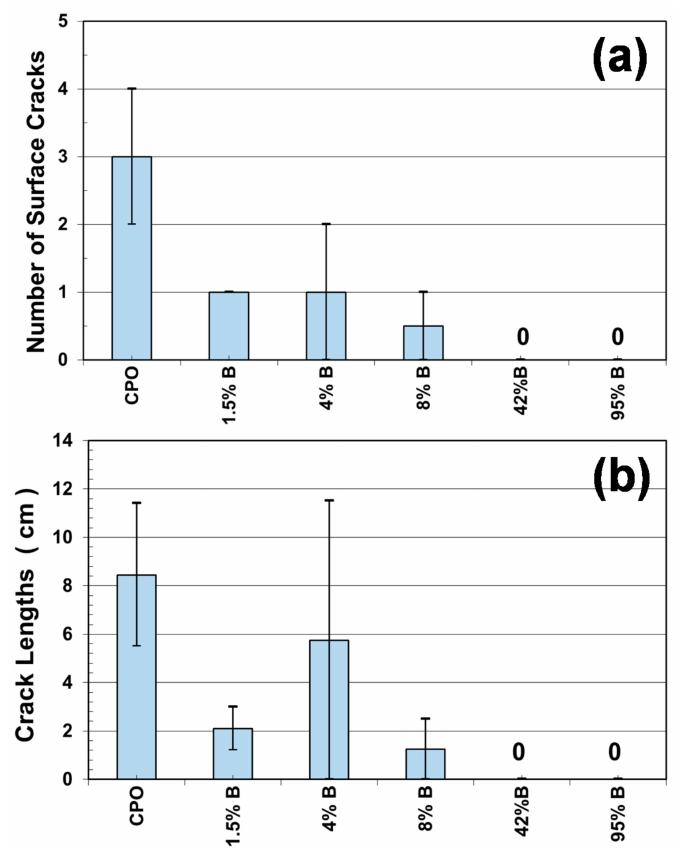
Figure 6. Results from the crack survey: ( a ) number of surface cracks and ( b ) crack length measure- ments per mortar